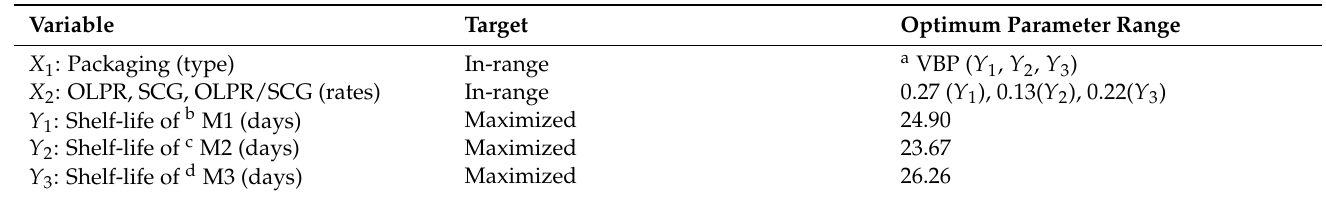
Table 7. Optimization results for extended shelf-life (days) of M 1 , M 2 , and M 3 stored at 4 ◦ C using the developed